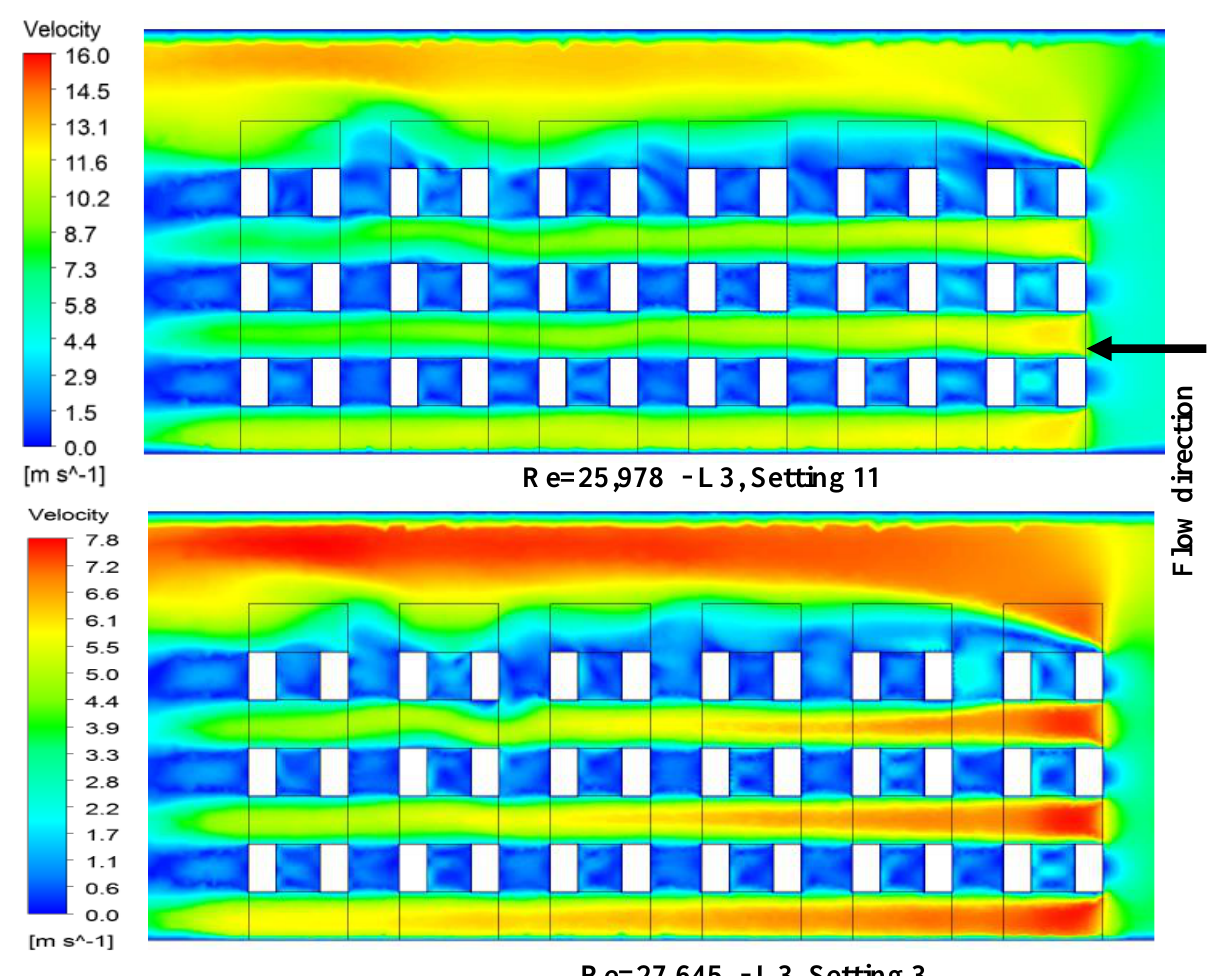
Figure 13. Velocity contours in a longitudinal channel between bricks in the first column.